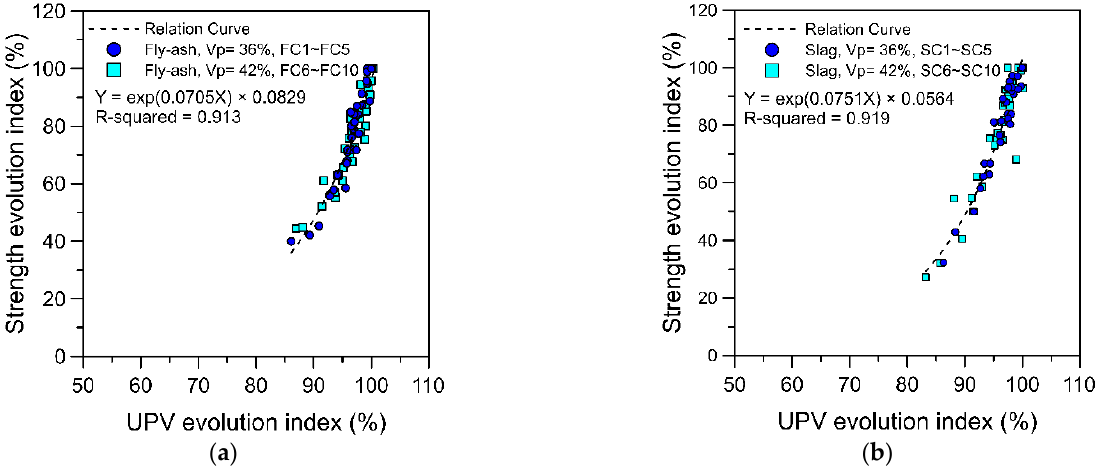
Figure 6. Effects of adding pozzolanic admixture and altering the paste volume ratio on the UPV and strength evolution index: ( a ) fly ash concrete; ( b ) slag concrete.